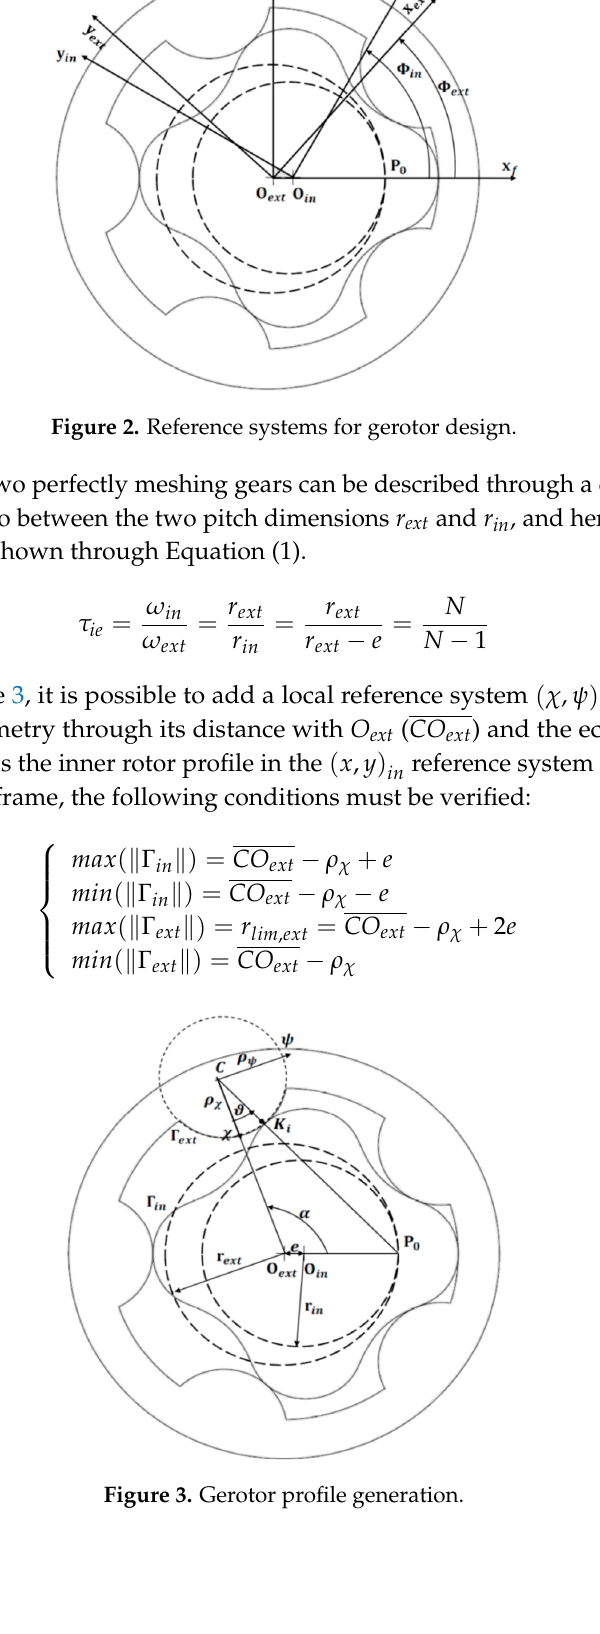
Figure 3. Gerotor profile generation.